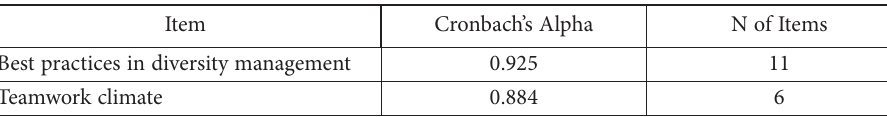
Table 3. Reliability statistics (source: own research)